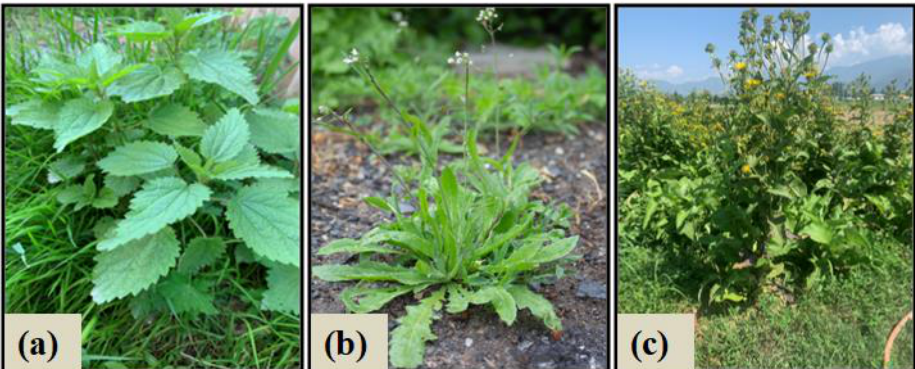
Figure 9. Illustration of the medicinal plants used for the study ( a ) Urtica dioica (Family: Urticaceae) ( b ) Capsella bursa-pastoris (Family: Brassicaceae) ( c ) Inula racemosa (Family: Asteraceae) commonly known as stinging nettle, shepherd’s purse and pushkarmool, respectively.